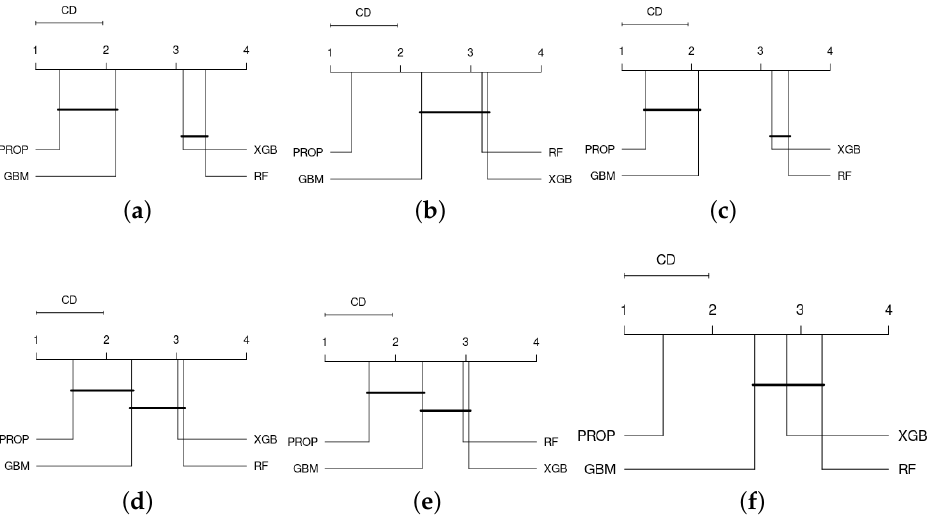
Figure 4. Critical difference plot using Nemenyi Test (significant level, α = 0.05) across performance metrics: F1 score ( a ), F2 score ( b ), Matthew correlation coefficient (MCC) score ( c ), accuracy score ( d ), area under ROC curve (AUC) score ( e ), and area under precision–recall curve (AUCPR) score ( f